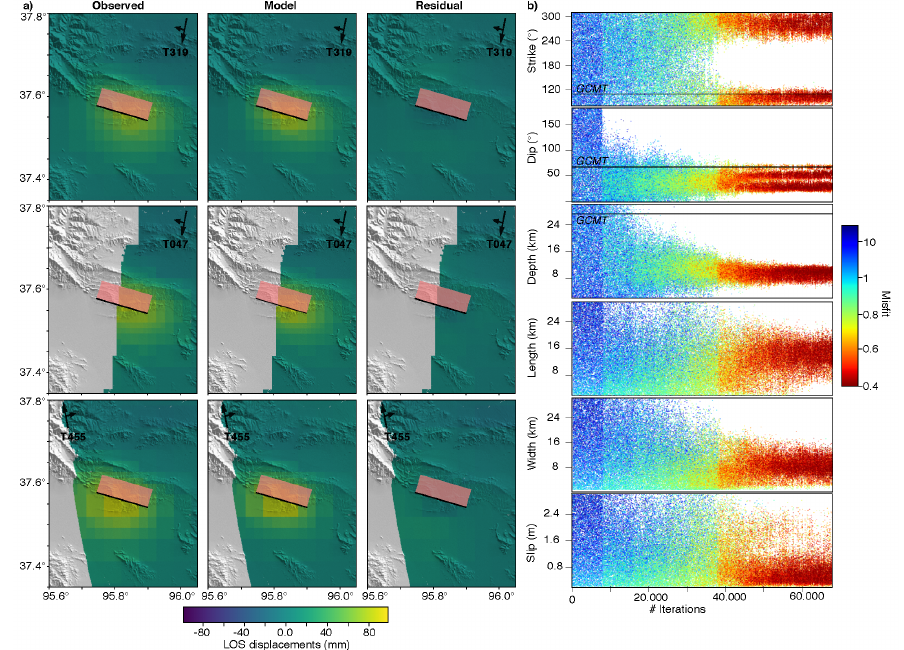
Figure 7. Posterior models for the 10 November 2008 earthquake obtained from the optimisation with a free dip-angle orientation based on both stack of long-baselines interferograms and teleseismic data. ( a ) Comparison between data and model from the optimisation. Left: sub-sampled surface displacements for tracks 319 (top), 047 (middle), and 455 (bottom). Middle: modeled displacements associated with the maximum likelihood of the posterior probability distribution. Right: residuals between the forward model and the observations. ( b ) Sequence plots for selected parameters of the optimisation with a color-scale that varies depending on the misfit from high (blue) to low (red). North-dipping and south-dipping bimodal solutions are explored simultaneously, as sampling in all regions is encouraged by random offsets. The Bayesian bootstrap inversion converges towards an 9.8 ± 1km deep plane dipping towards the north with an angle of 32 ± 10 ◦